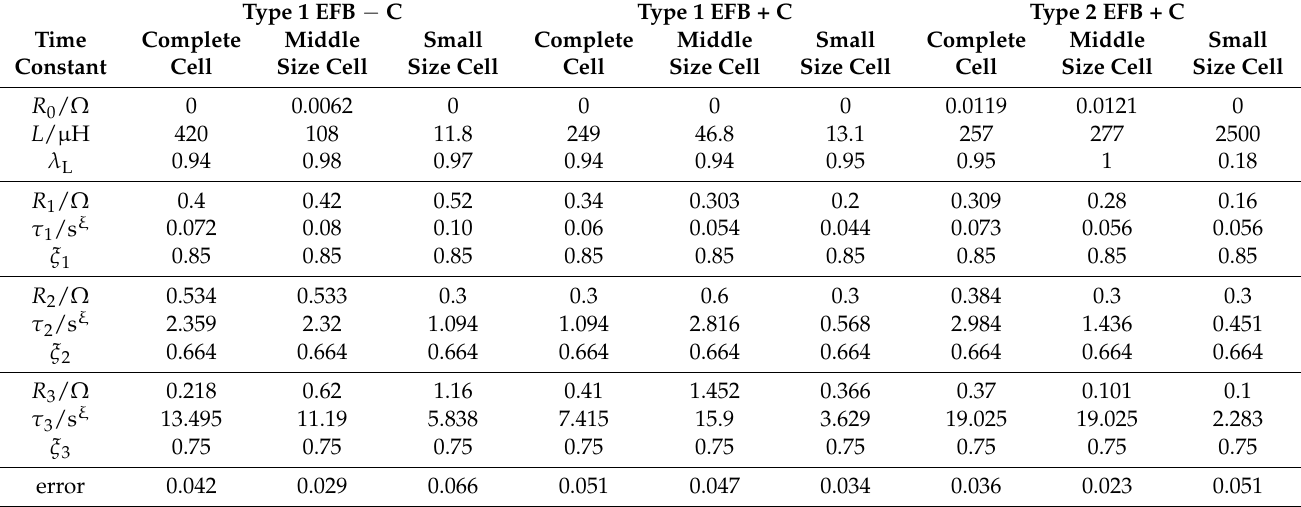
Table 6. Parameters for the ECM fit and